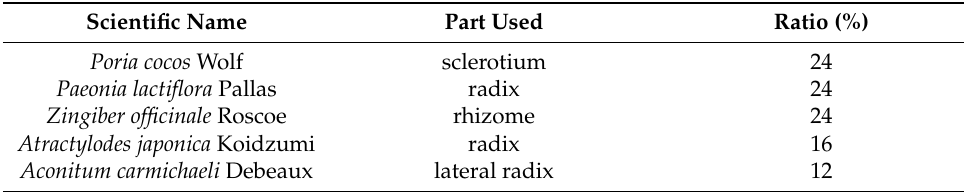
Table 6. Composition of Jinmu-tang